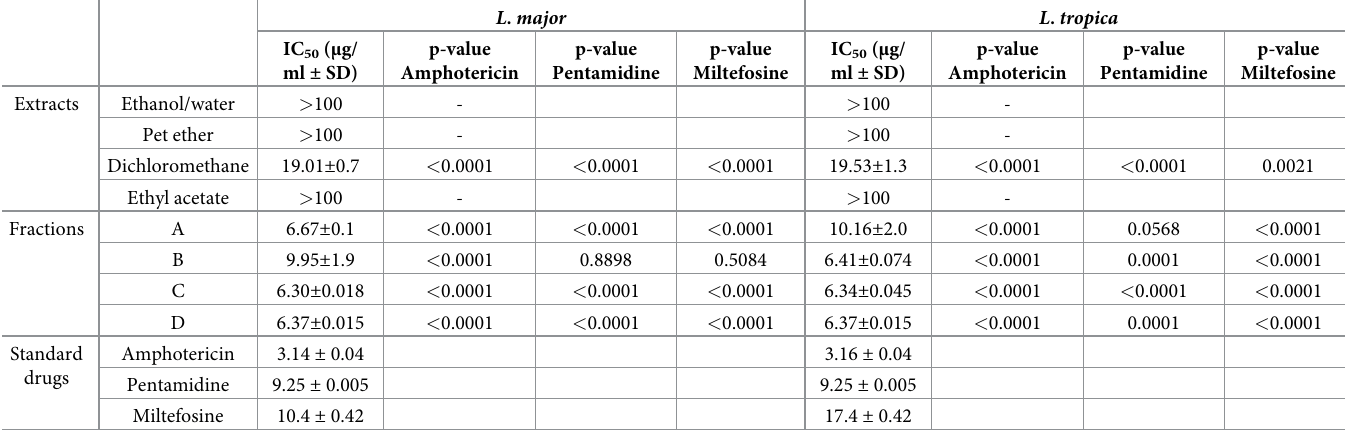
Table 2. Anti-leishmanial activity of extracts and fractions against L . major and L . tropica .